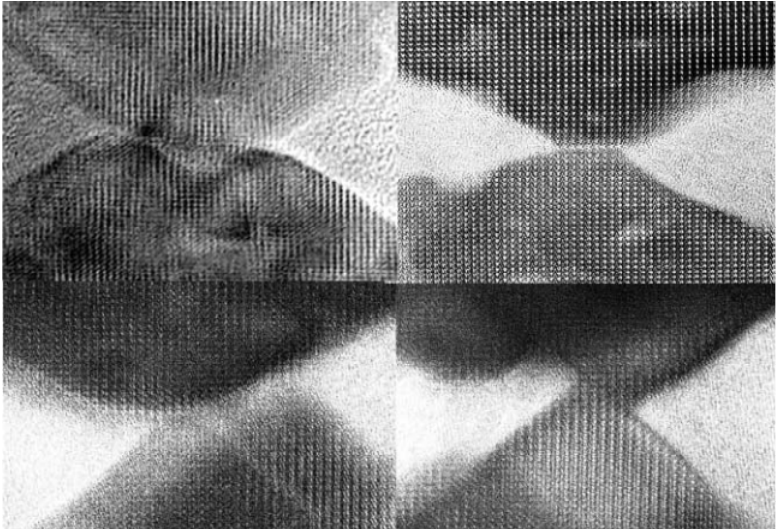
Figure 6. Cross-section of abalone nacre showing the detailed structure at the lamellae boundaries with arrows to highlight some of the locations where nanoasperities